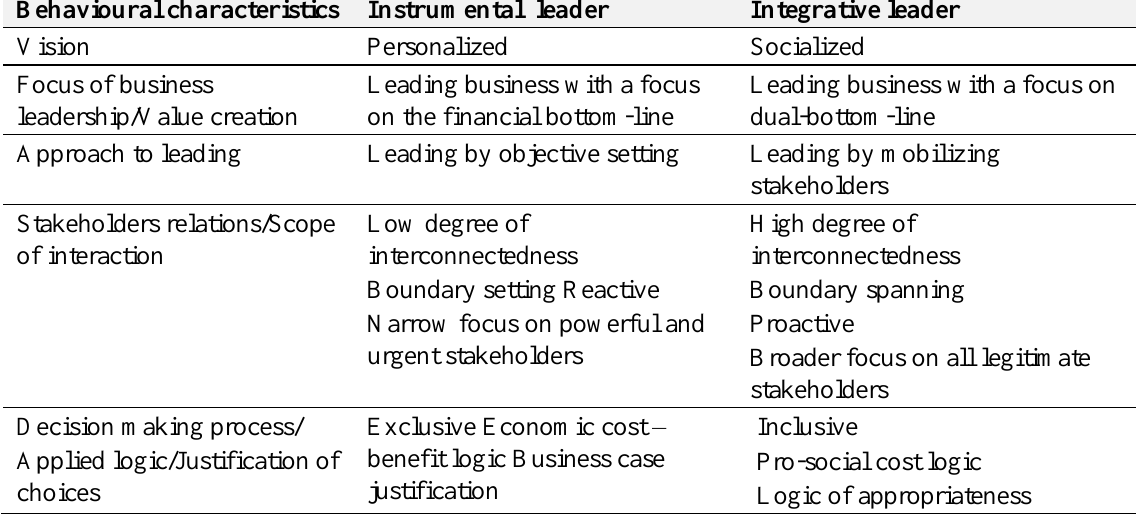
Table 1. Responsible leadership